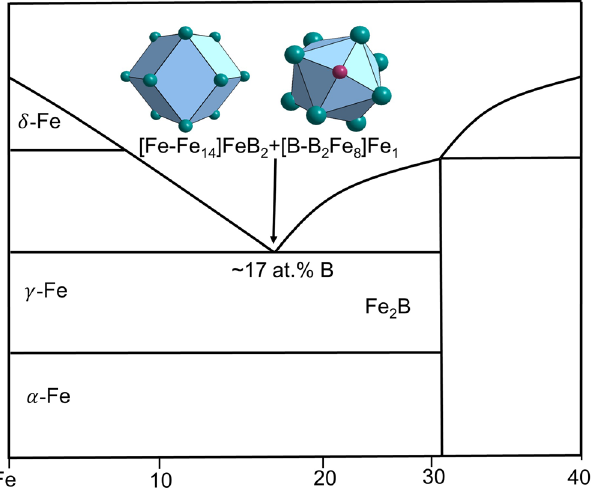
Figure 3. Interpretation of Fe 83 B 17 eutectic point using a dual-cluster formula [Fe-Fe 14 ]FeB 2 + [B-B 2 Fe 8 ]Fe 1 , with the two clusters being derived respectively from eutectic phases δ -Fe (W type) and BFe 2 (AlCu 2 ).